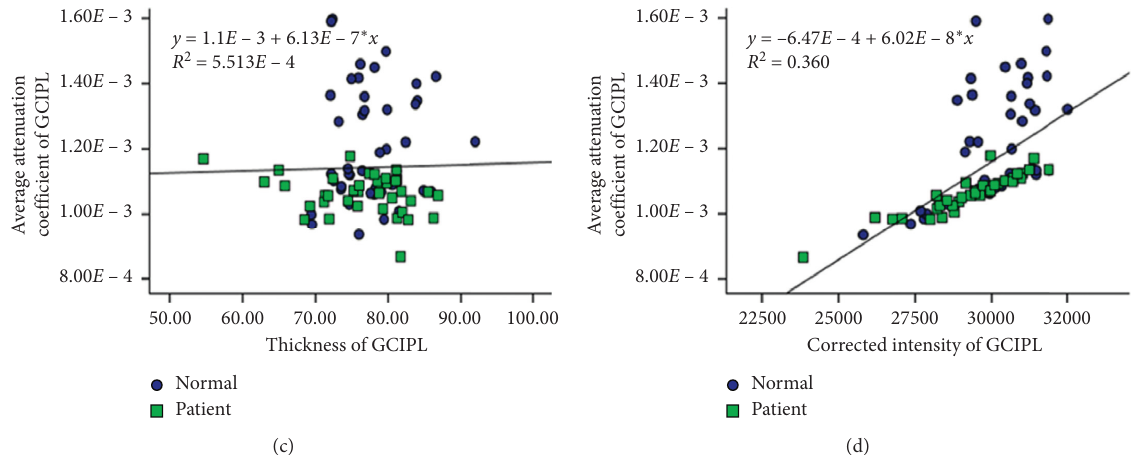
Figure 4: Linear regression analyses of the attenuation coefficient, the thickness, and the corrected intensity in the overall RNFL and